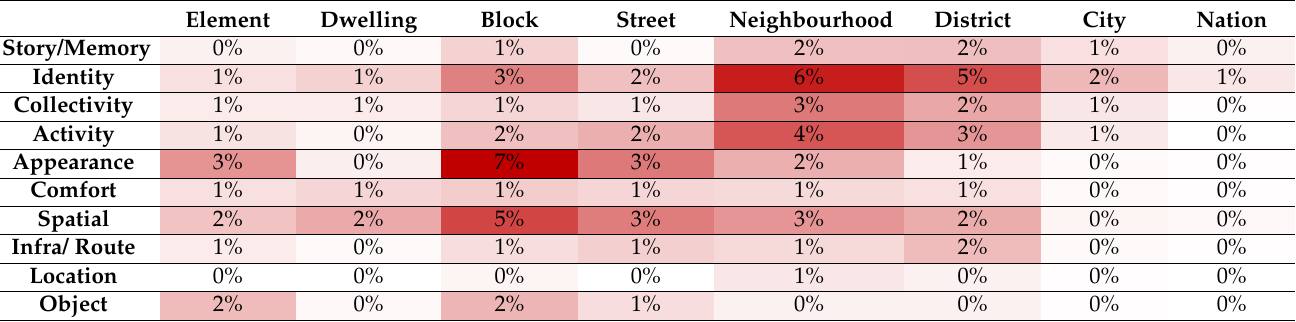
Table logic: rows show attribute categories and columns show scale levels. The cells show the percentage of the total quotations of this combination. Table A1. Total sample: 59 respondents.